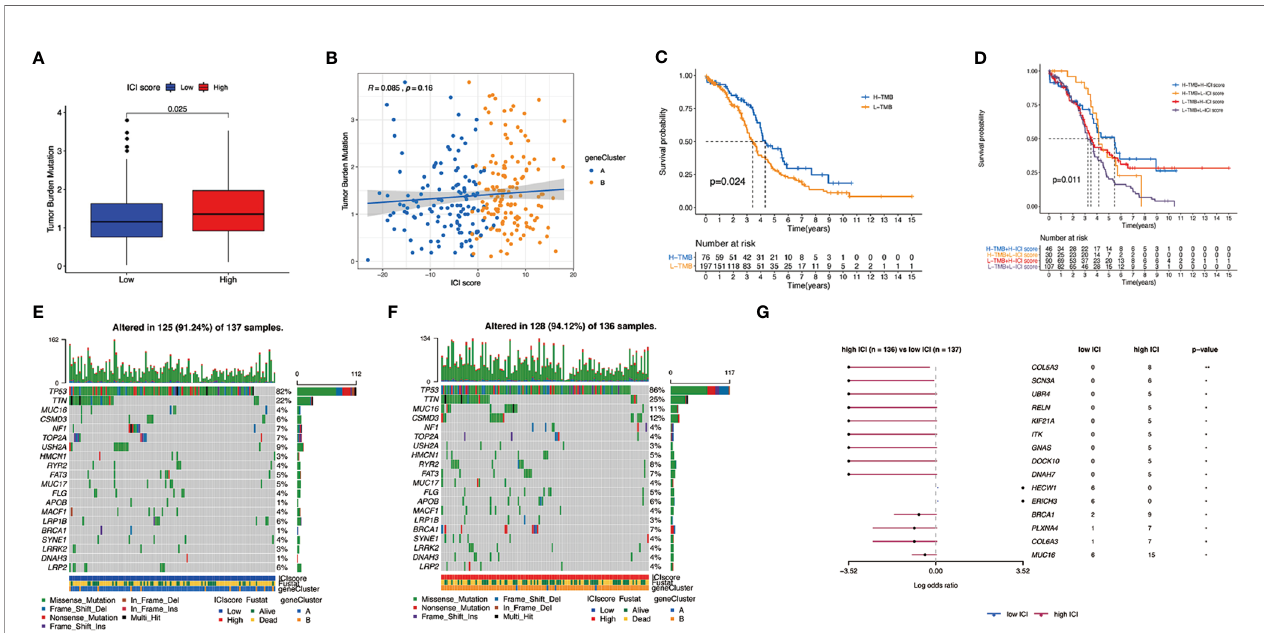
FIGURE 6 | The association between the ICI scores and somatic variants. (A) Tumor mutation burden (TMB) difference in the high and low ICI subgroups. (B) Scatterplots describing the positive correlation between ICI scores and TMB in the OC cohort. (C) Kaplan – Meier curves for high and low TMB groups of the OC cohort. (D) Kaplan – Meier curves for patients in the OC cohort strati fi ed by both TMB and ICI scores. (E) The single nucleotide variants (SNVs) were constructed using high ICI on the left (blue) and (F) low ICI on the right (red). Individual patients are represented in each column. (G) Differentially mutated genes between low ICI and high ICI displayed as a forest